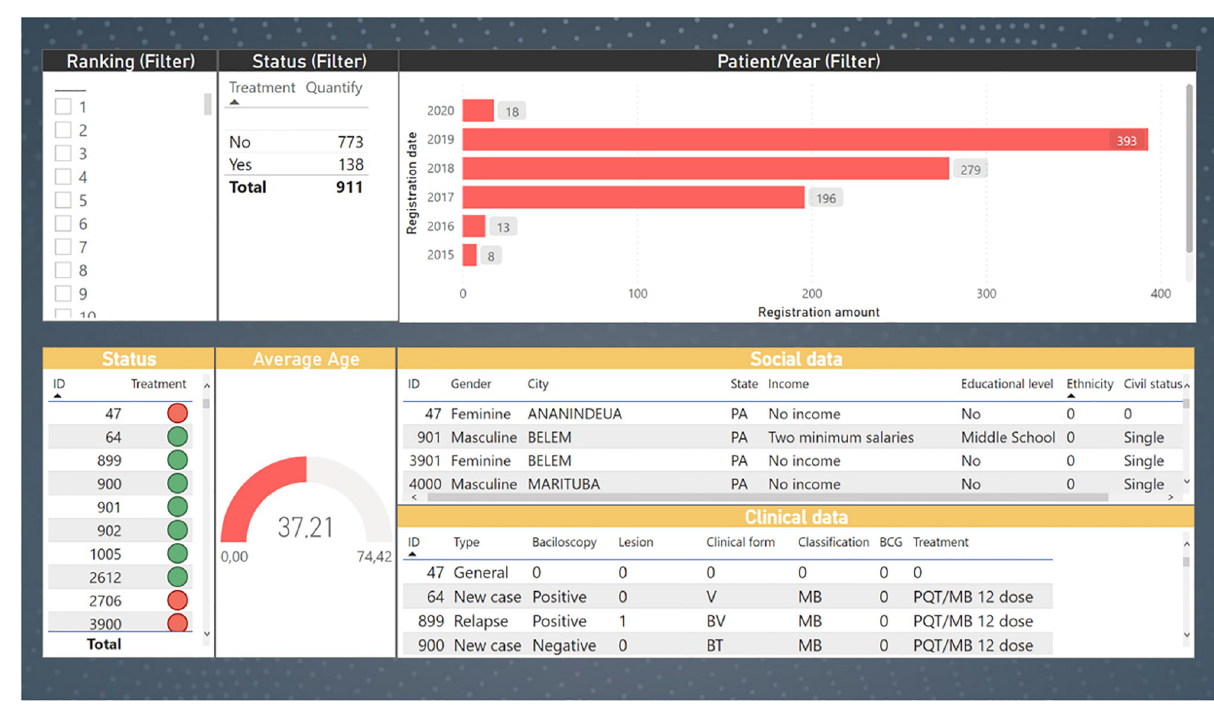
Fig 6. Data visualization dashboard. The figure shows an interactive dashboard designed for data